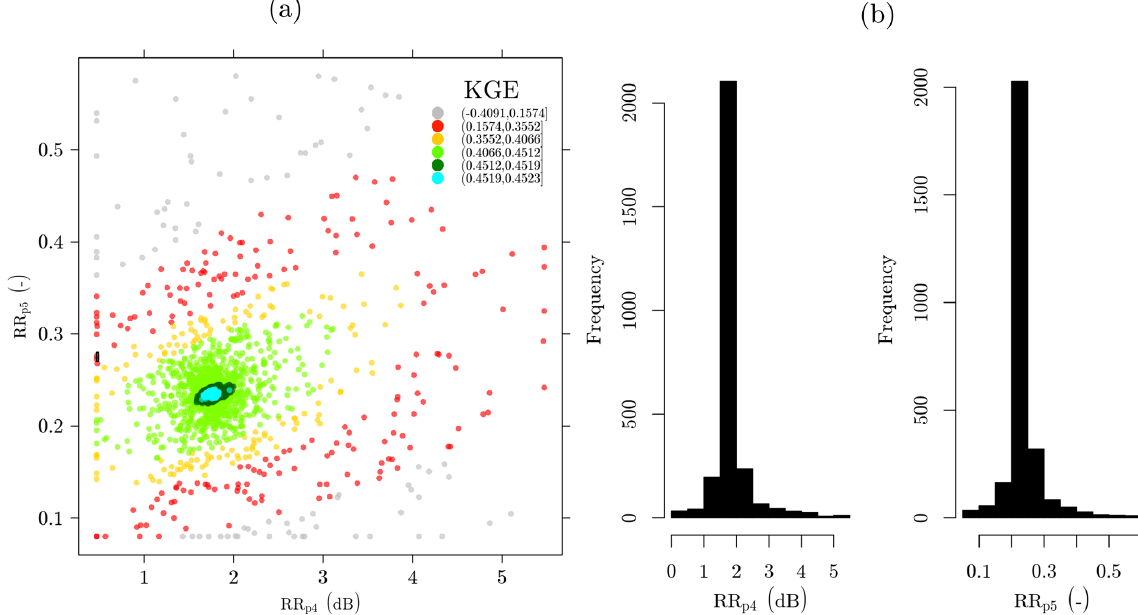
Figure 3. Rainfall retrieval performance projected onto the parameter space: dotty plot showing the interaction between calibration parame- ters at different Kling–Gupta efficiency (KGE)